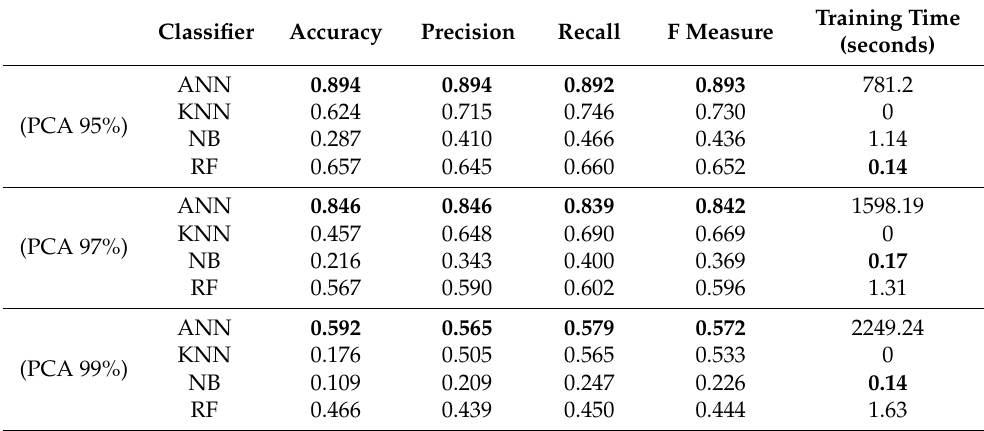
Table 10. Identification results of VGG-19-deep features obtained by maximizing (F6 and F7) after applying PCA. Bold values signify the best performance.